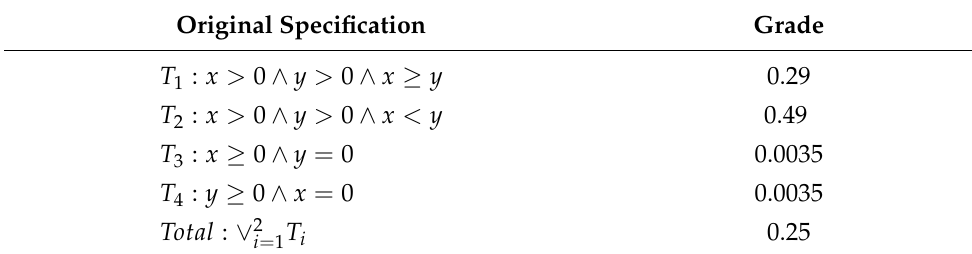
Table 6. Results for process gcd with original specifications.